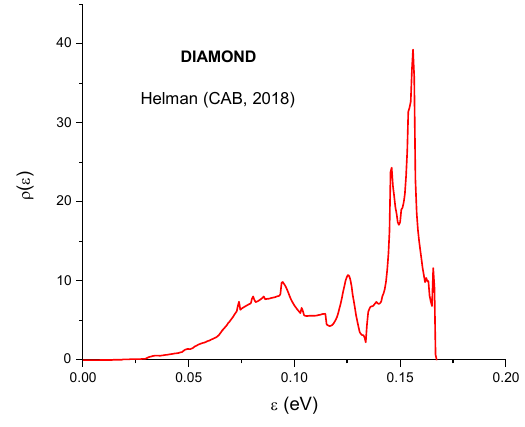
Fig. 1 : Our calculated phonon density of states of diamond obtained by DFT calculation.